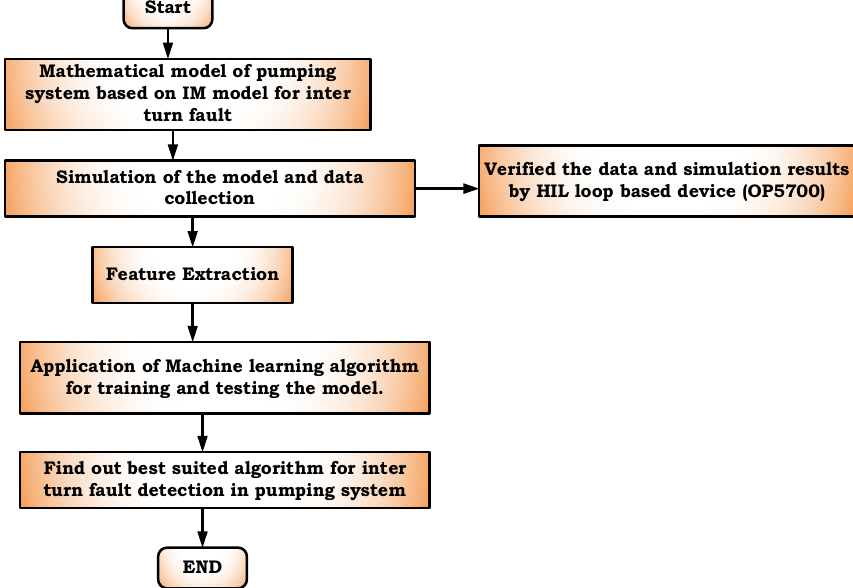
Figure 1. Flow chart of inter turn fault detection in induction motor-based pumping